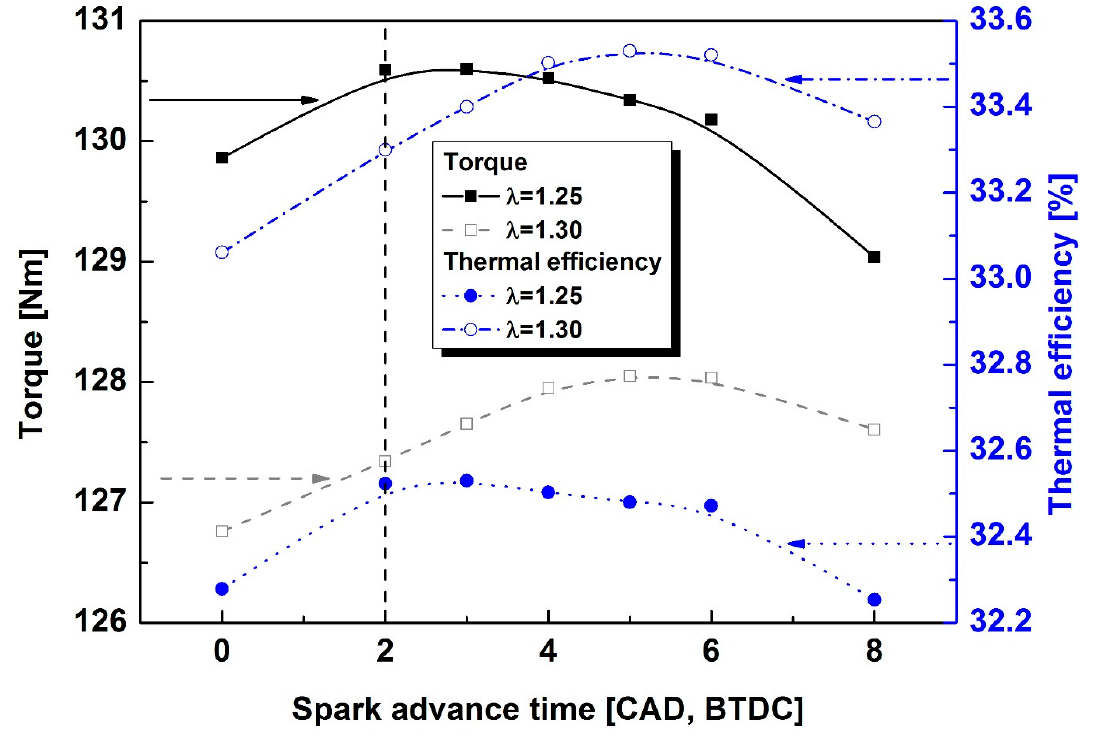
Figure 3. Torque and thermal efficiency variations with spark advance time changes at excess air ratios of 1.25 and 1.30.